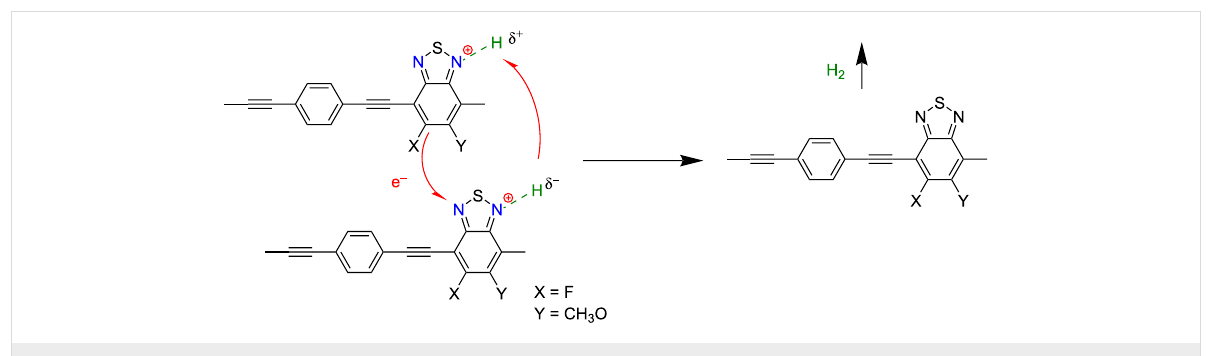
Figure 6: The mechanism of PCET-enhanced H 2 formation; see